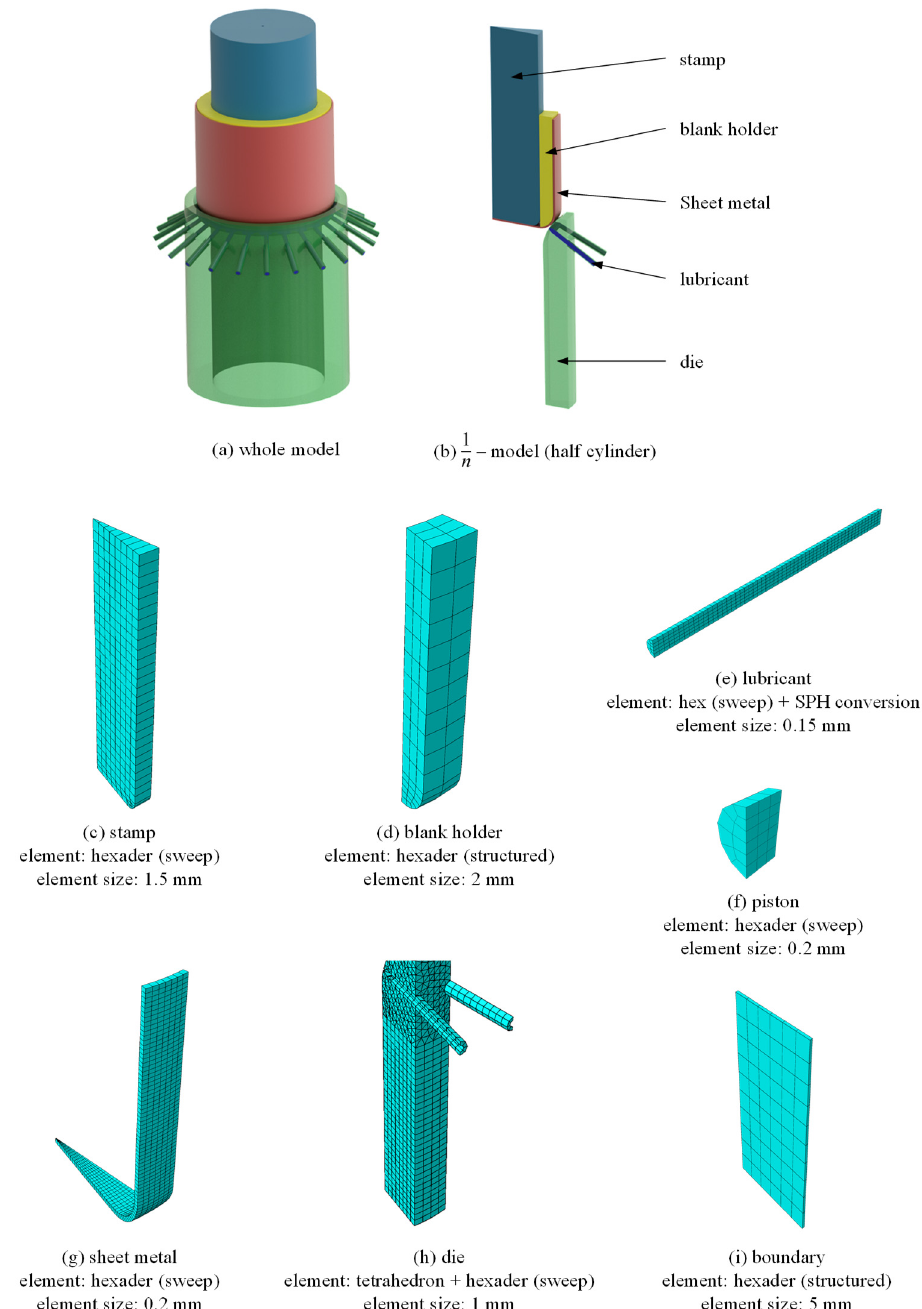
Figure 4. Simulation approaches of the coupled SPH and forming simulation ( a , b ), mesh representation of the individual components of the 1/ n model ( c – i ).